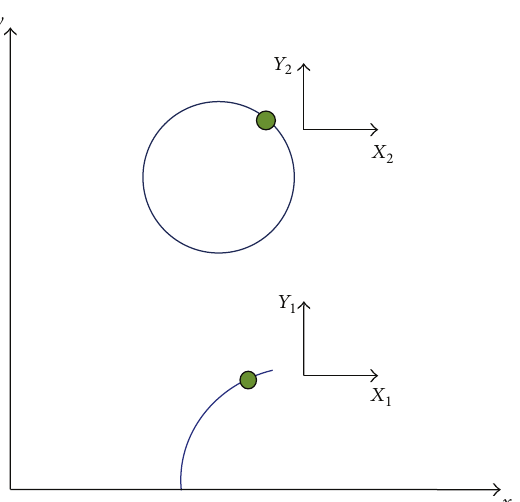
Figure 10: Lagrangian coordinate systems defined in the Eulerian solution domain.